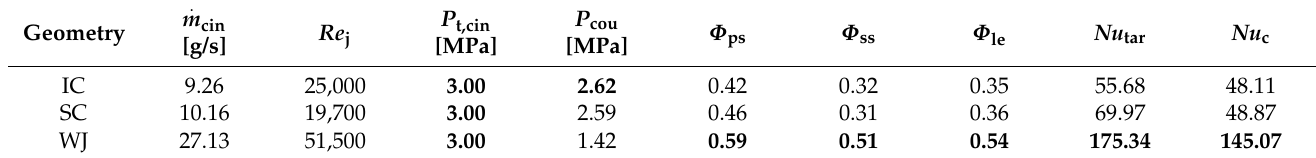
Table 5. Flow and heat transfer and parameters of the cases with the same coolant inlet total